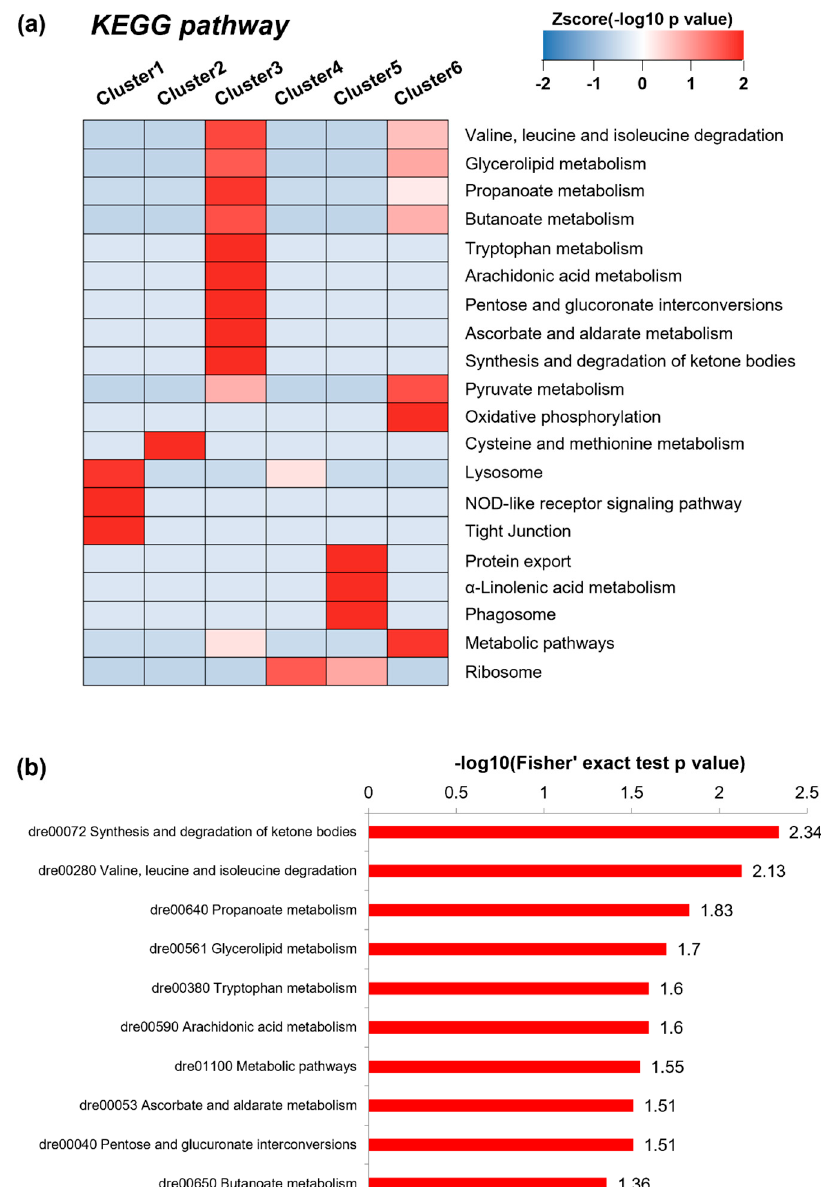
Figure 3. ( a ) KEGG pathway-based enrichment analysis in clusters 1~6. The enrichment efficiency was evaluated by − log 10 of p values. ( b ) KEGG pathway-based enrichment analysis using proteins grouped in cluster 3. The Fisher’s exact test p value was used to evaluate the enrichment efficiency.